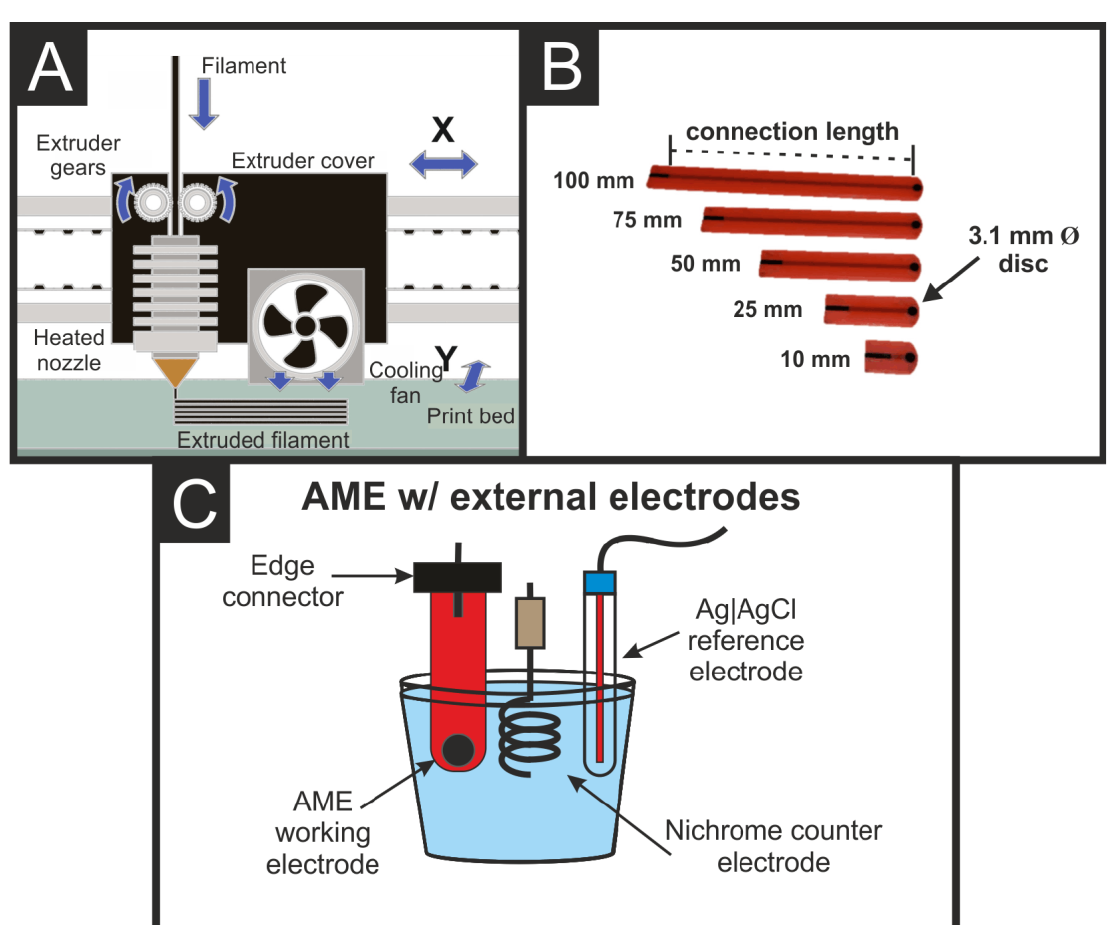
Figure 1. ( A ) Schematic representation of the printer head for an FFF printer, highlighting the different parts and layer-on-layer print of the extruded filament. ( B ) Photograph of the printed 3.1 mm diameter AMEs with different connection lengths (100, 75, 50, 25, and 10 mm). ( C ) Schematic of the experimental set-up used throughout this work, utilizing an additively manufactured working electrode connected through an edge connector, Ni coil counter electrode, and Ag|AgCl reference